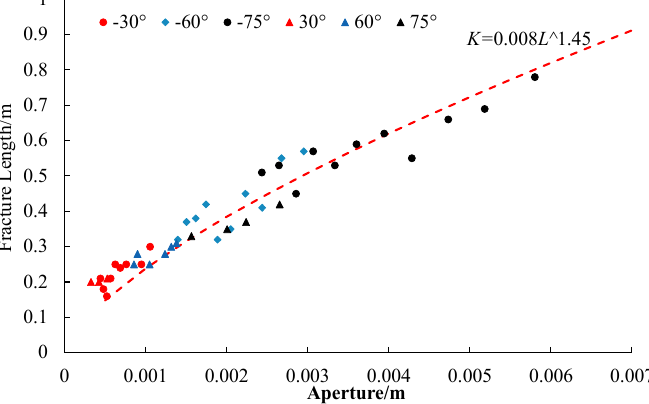
Figure 9. Fitting diagram of aperture of fracture along the bedding plane.